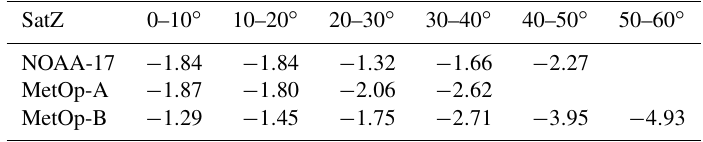
Table 5. The mean shift for each range of SatZ in the across-track direction. The unit of the shift is